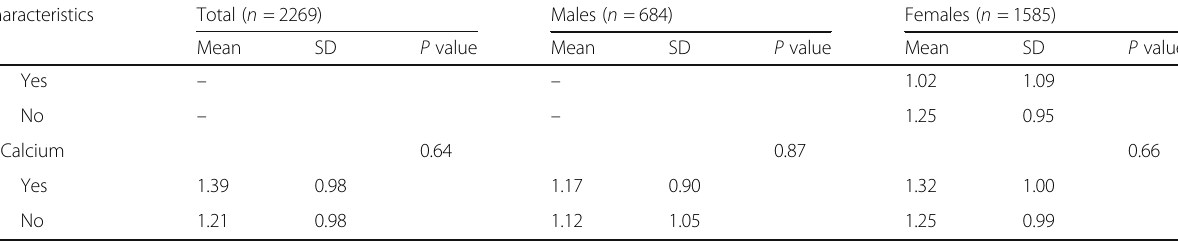
Table 6 Dietary Inflammatory Index, according to gender and concomitant diseases (Continued)